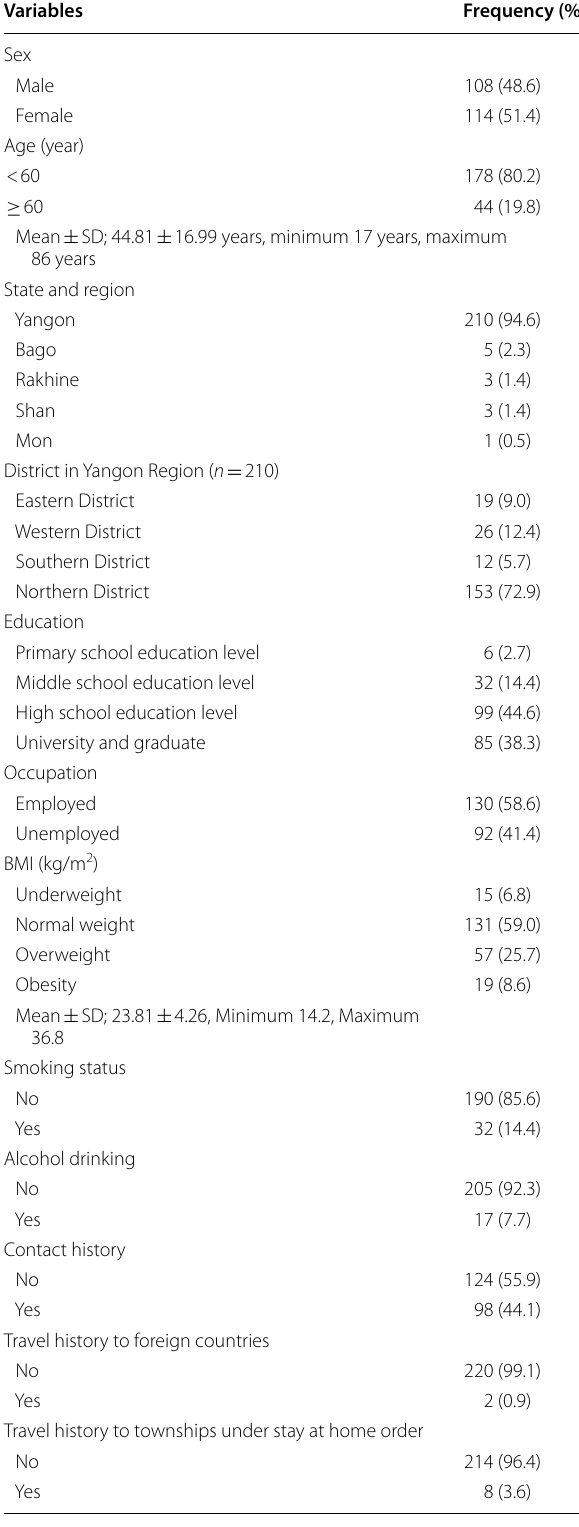
Table 1 Demographic characteristics of COVID-19